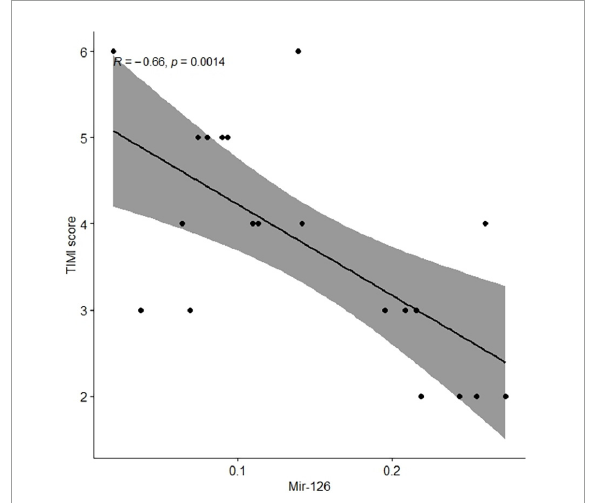
FIGURE2 Levels of extracellular vesicle-associated miR-126 in coronary blood of patients with AMI were negatively associated with TIMI scores. AMI, acute myocardial